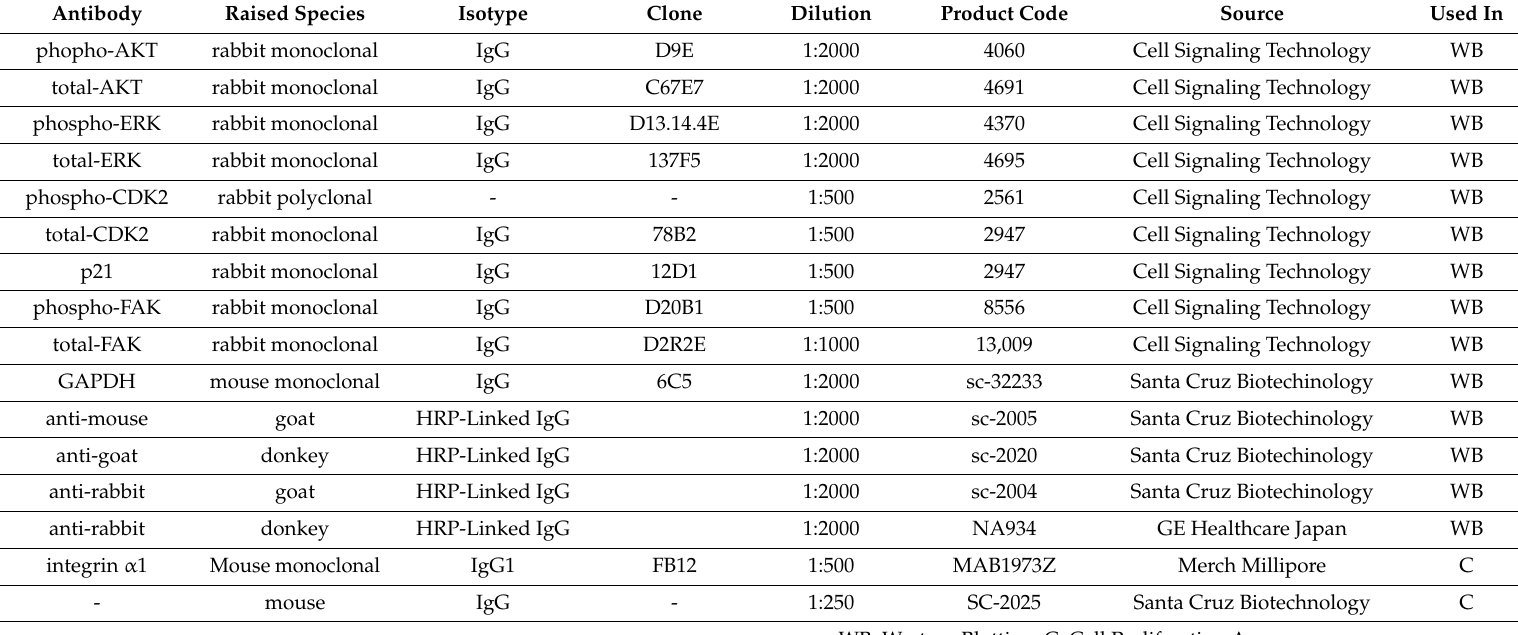
Table 2. Antibodies Used in the